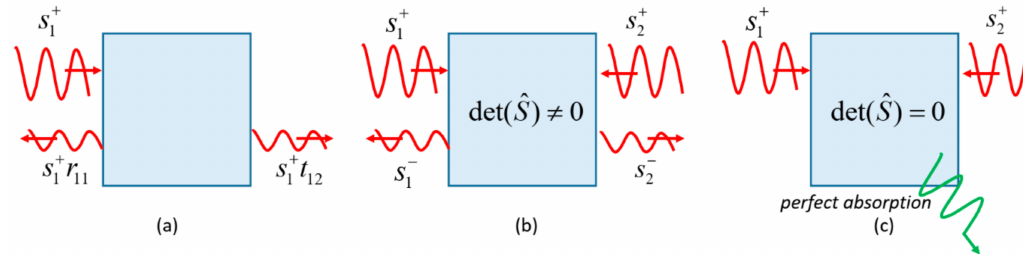
Figure 2. System with two channels, for example, dielectric resonator slab. ( a ) Excitation of this t 12 ) and reflection ( s + r 11 ). system from one channel by a wave s + results in partial transmission ( s + 1 1 1 ( b ) Excitation by two waves from both channels ( s + and s + ) result in outgoing waves in both channels 2 1 ) if det ( ˆ S ) (cid:44) 0. ( c ) Tailoring the structure geometry (thickness) and adding loss causes CPA ( s − and s − 2 1 regime (det ( ˆ S ) = 0 ), when all incoming energy gets dissipated. Changing of relative amplitude or causes changing of mutual absorption and phase of s + and s + 2 1